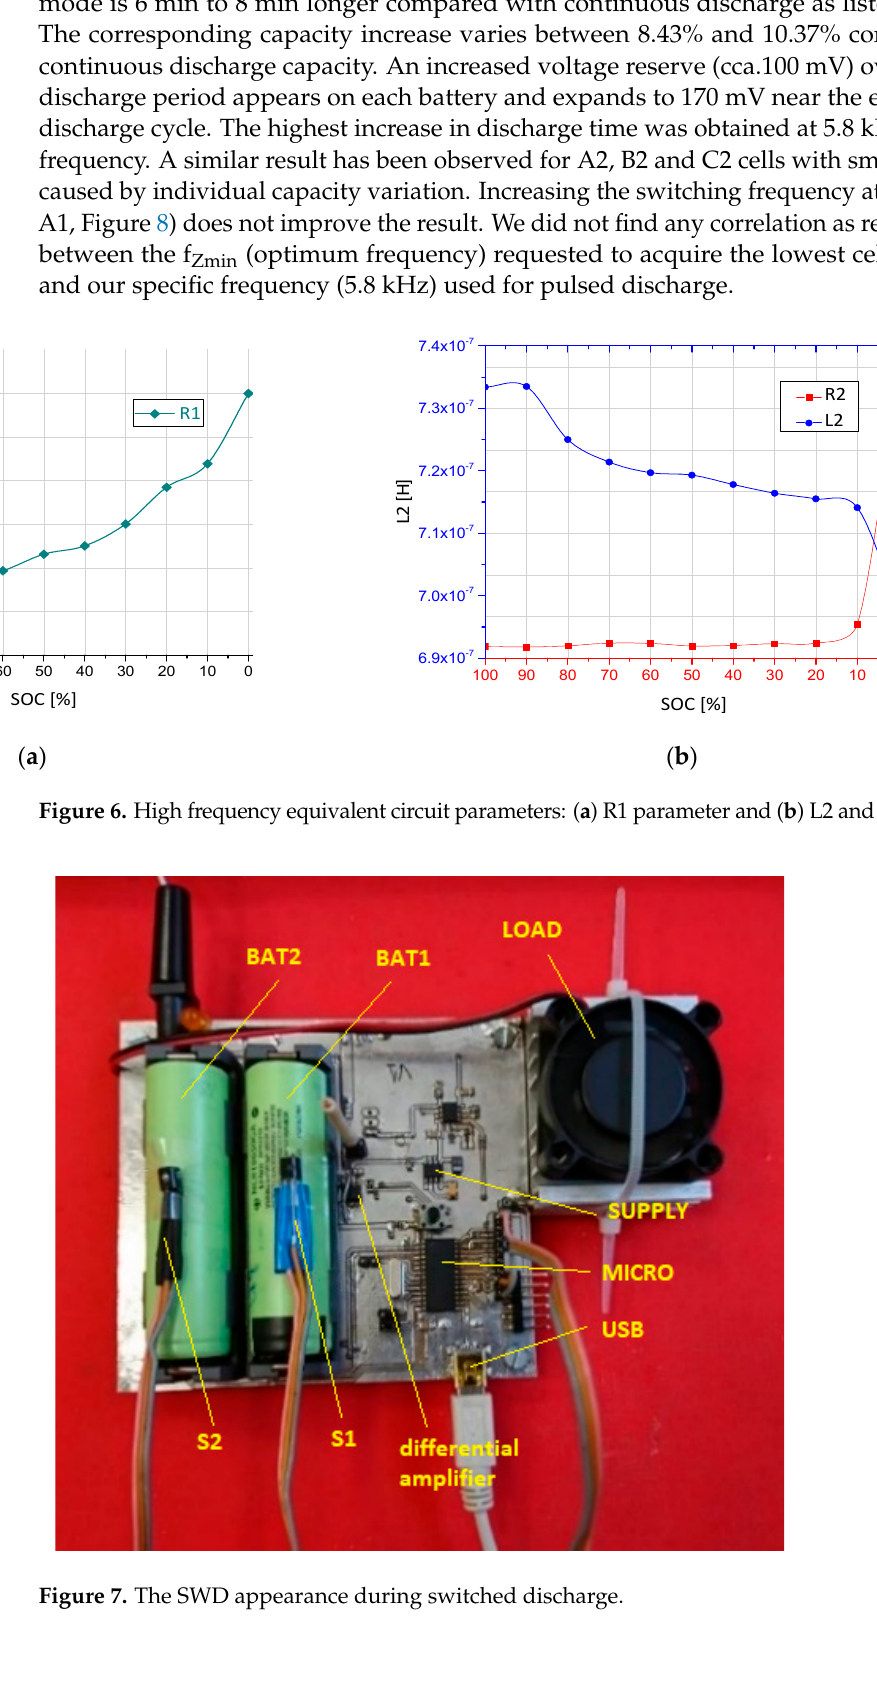
Figure 7. The SWD appearance during switched discharge.